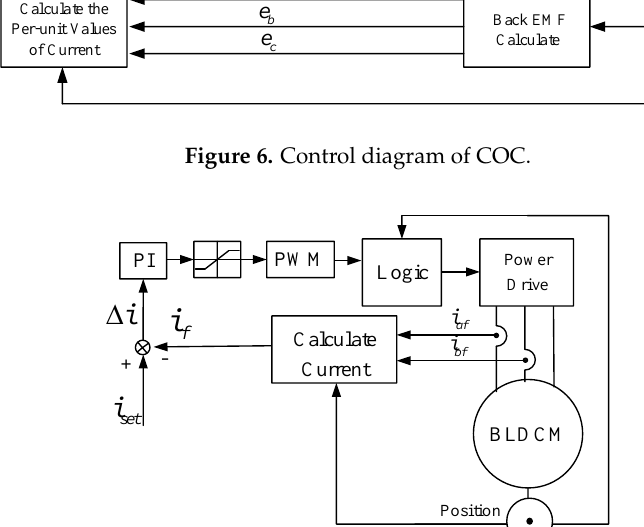
Figure 6. Control diagram of COC.